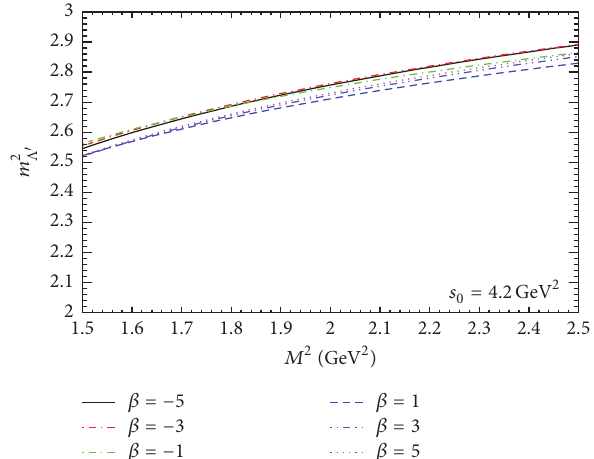
Figure 2: Dependence of 𝑚 2 Λ 󸀠 on the Borel mass parameter 𝑀 2 for the fixed value of the continuum threshold 𝑠 0 = 4.2 GeV 2 is depicted for the several fixed values of parameter 𝛽 .